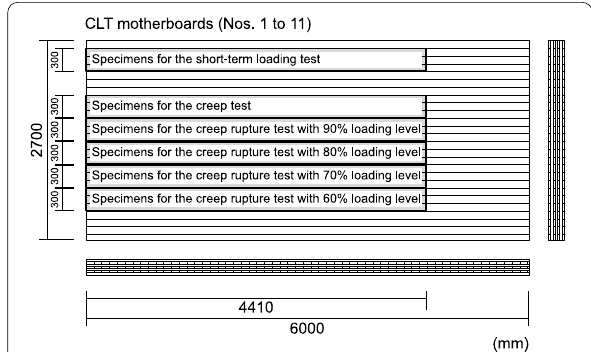
Fig. 1 Cutting pattern of specimens from CLT motherboards